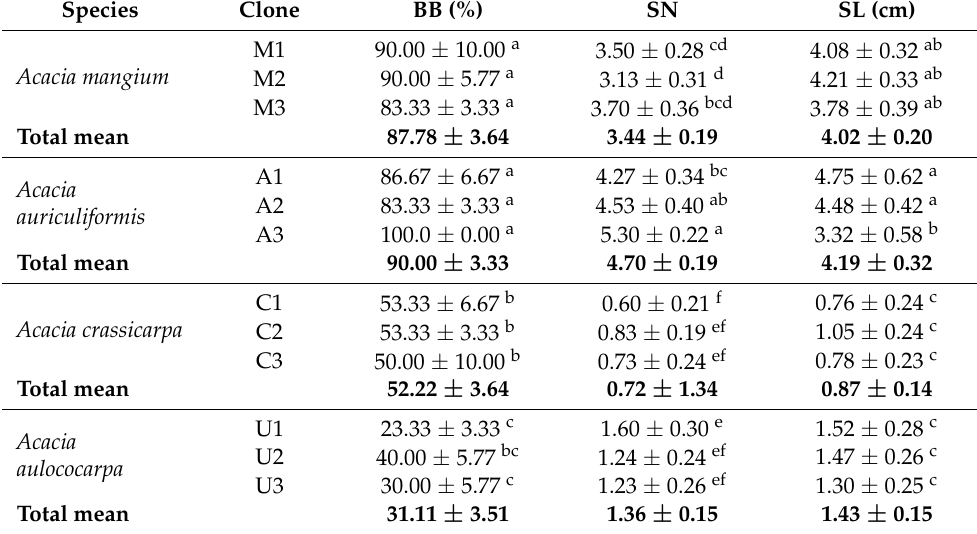
Table 3. Mean values for force-flushing (bud break) ability of cuttings of twelve clones of four Acacia species clones.